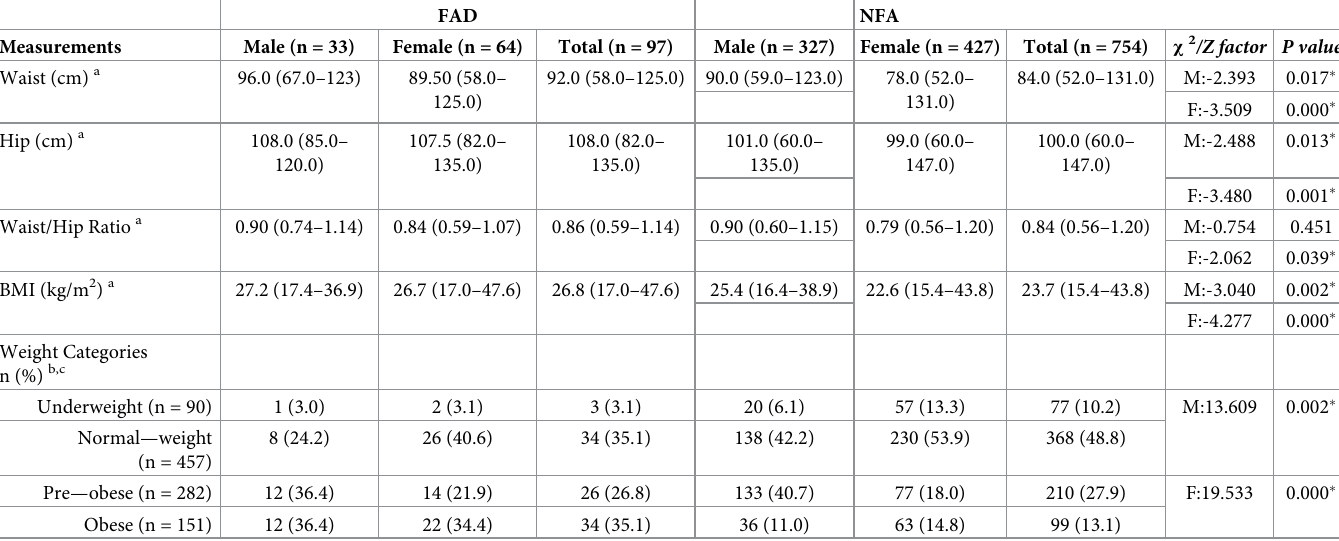
Table 2. Anthropometric measurements categorized by presence of food addiction by gender.